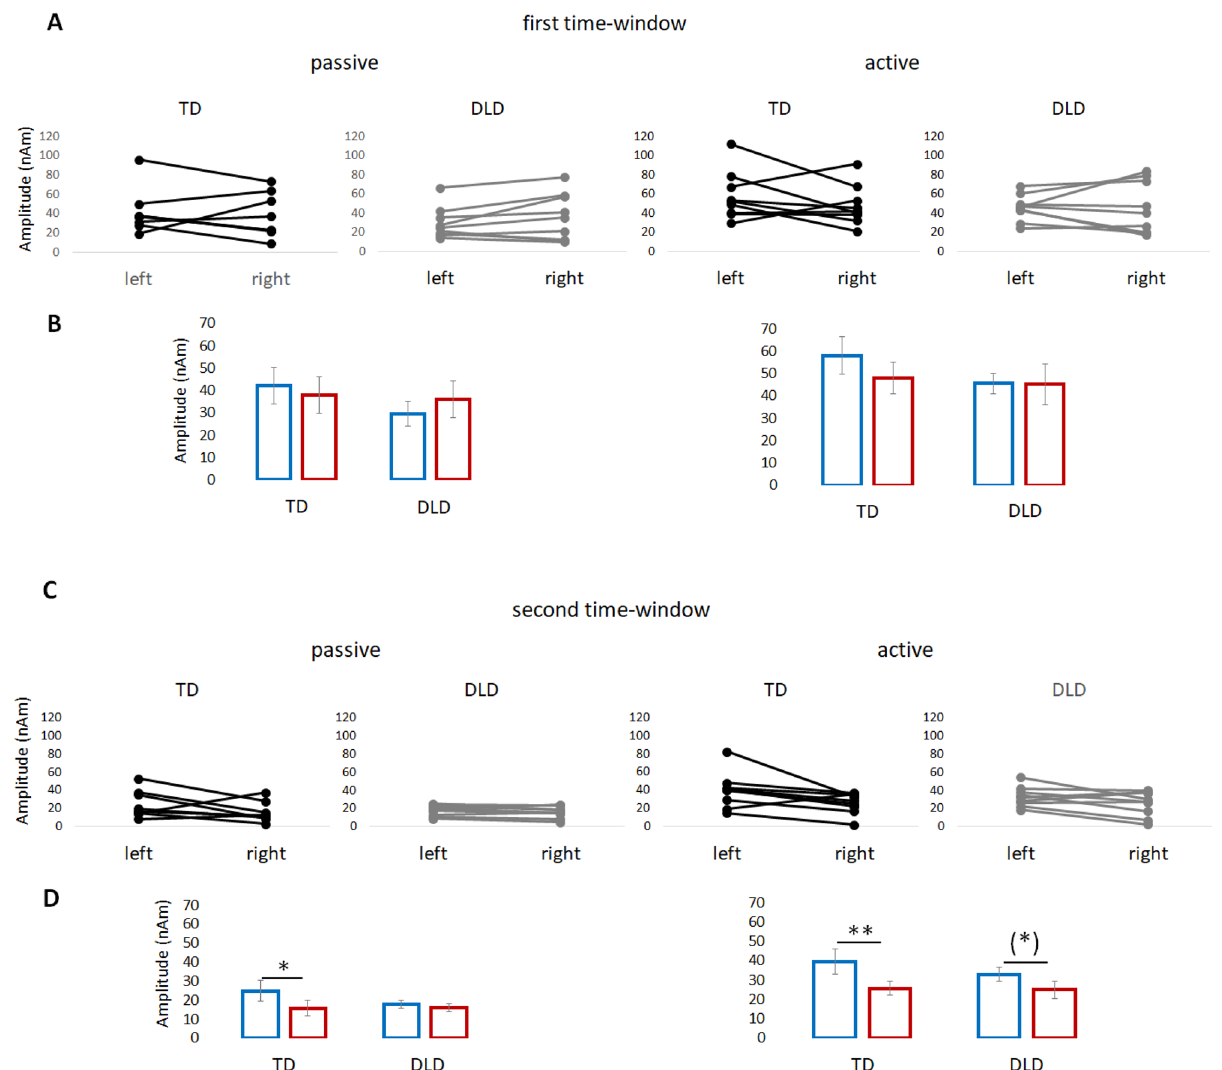
Figure 1. Main results in both time windows. ( A ) Comparison of the individual strength of activation between the left and right hemispheres in response to passive and active conditions in the first time window for children with DLD (gray) and children with TD (black). ( B ) Comparison of the averaged activation between the left (blue) and right (red) hemispheres in response to active and passive conditions in the first time window for children with DLD and children with TD. ( C ) Comparison of the individual strengths of activation between the left and right hemispheres in response to passive and active conditions in the second time window for children with DLD (gray) and children with TD (black). ( D ) Comparison of the averaged activation between the left (blue) and right (red) hemispheres in response to active and passive conditions in the second time window for children with DLD and children with TD. Whiskers represent the standard error of the mean